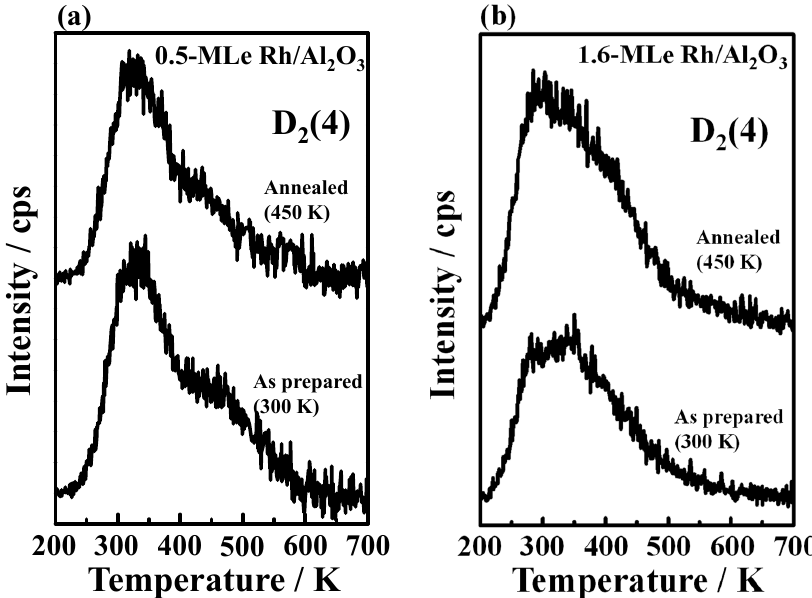
Figure 6. Temperature programmed desorption (TPD) spectra of D 2 ( m / z = 4 u) from 2.0-L CD 3 OD adsorbed on ( a ) 0.5- and ( b ) 1.6-MLe Rh clusters / Al 2 O 3 / NiAl(100) as prepared at 300 K (lower panels) and annealed to 450 K (upper panels).